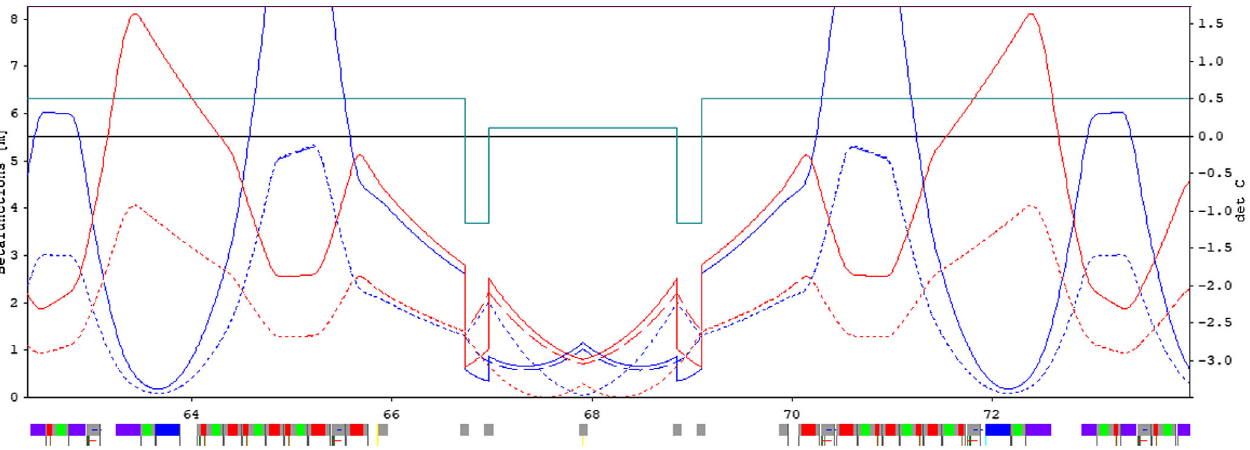
FIG. 7. Möbius insertion in straight 4 of the SLS 2.0 storage ring. Solid lines show the normal mode beta functions (blue a -mode, red b -mode), dashed and dotted lines the projected beta functions β determinant of the coupling matrix det C ¼ 1 − g 2 (axis at